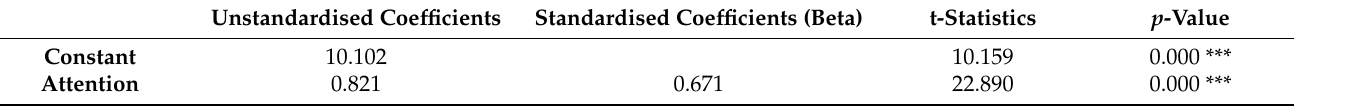
Table 2. Simple regression